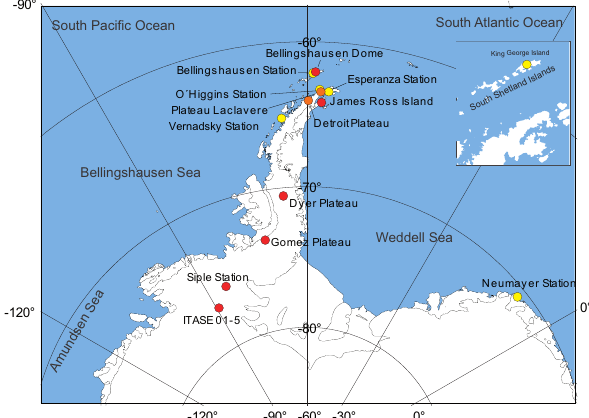
Fig. 1. Map showing all locations mentioned in this paper, as sta- tions in Antarctica (yellow dots), ice/firn core retrieve locations (red points), and ongoing and future research areas (orange dots).